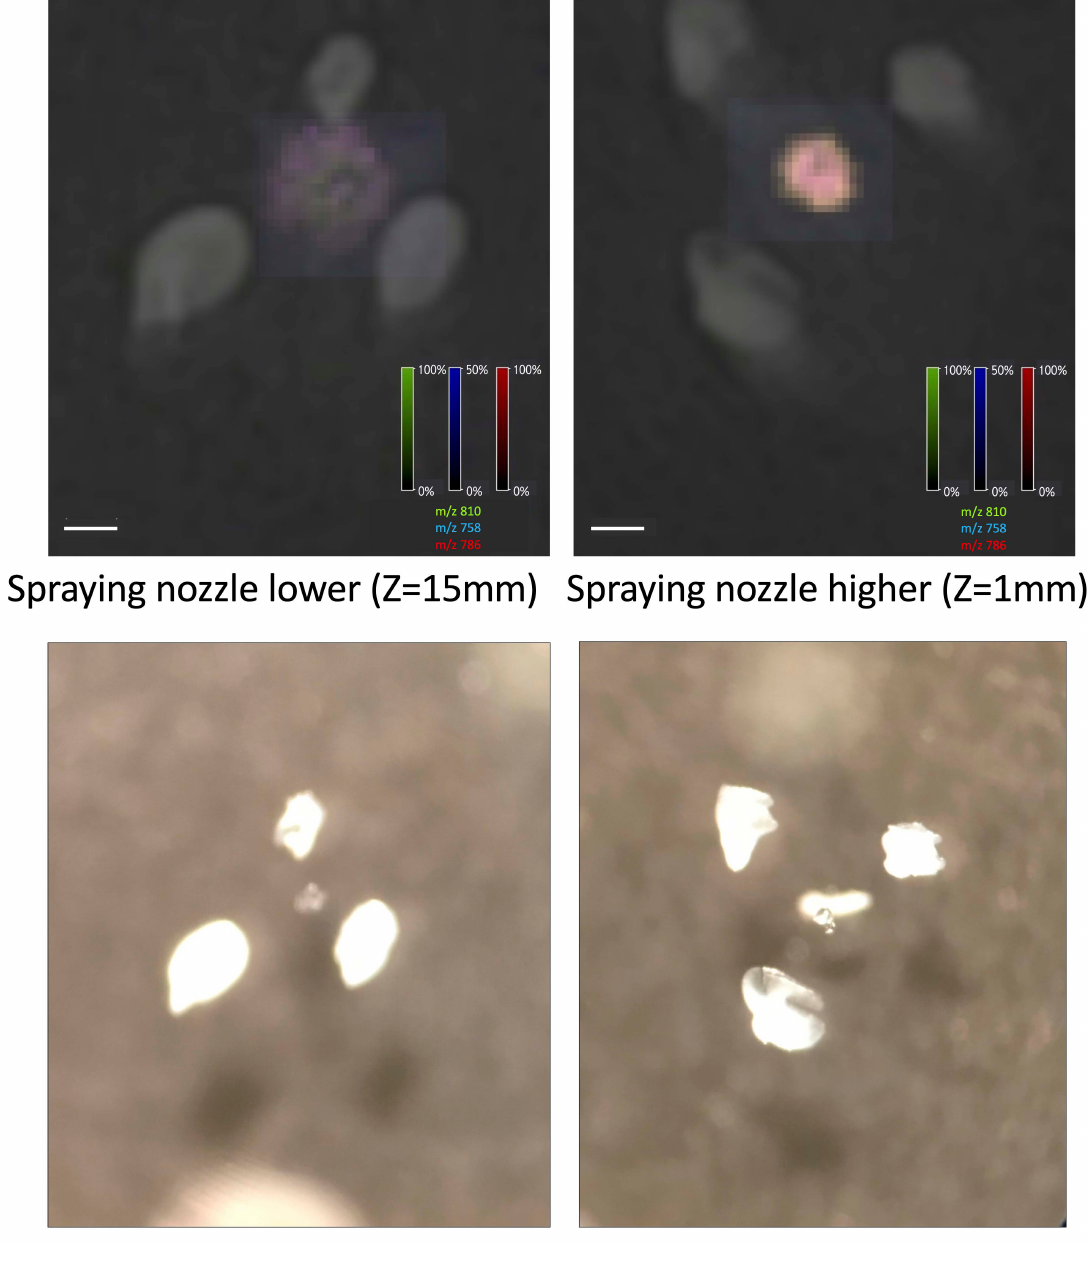
Figure 4. The picture of the oocyte obtained after matrix application at a lower nozzle position (Z = 15) and higher nozzle position (Z = 1), positive ionization mode, number of matrix layers: ten (L = 10), size bar: 200 µ m). At lower position the content of the cell is going out of it (“splashing”). Below it is presented the microscopic image of